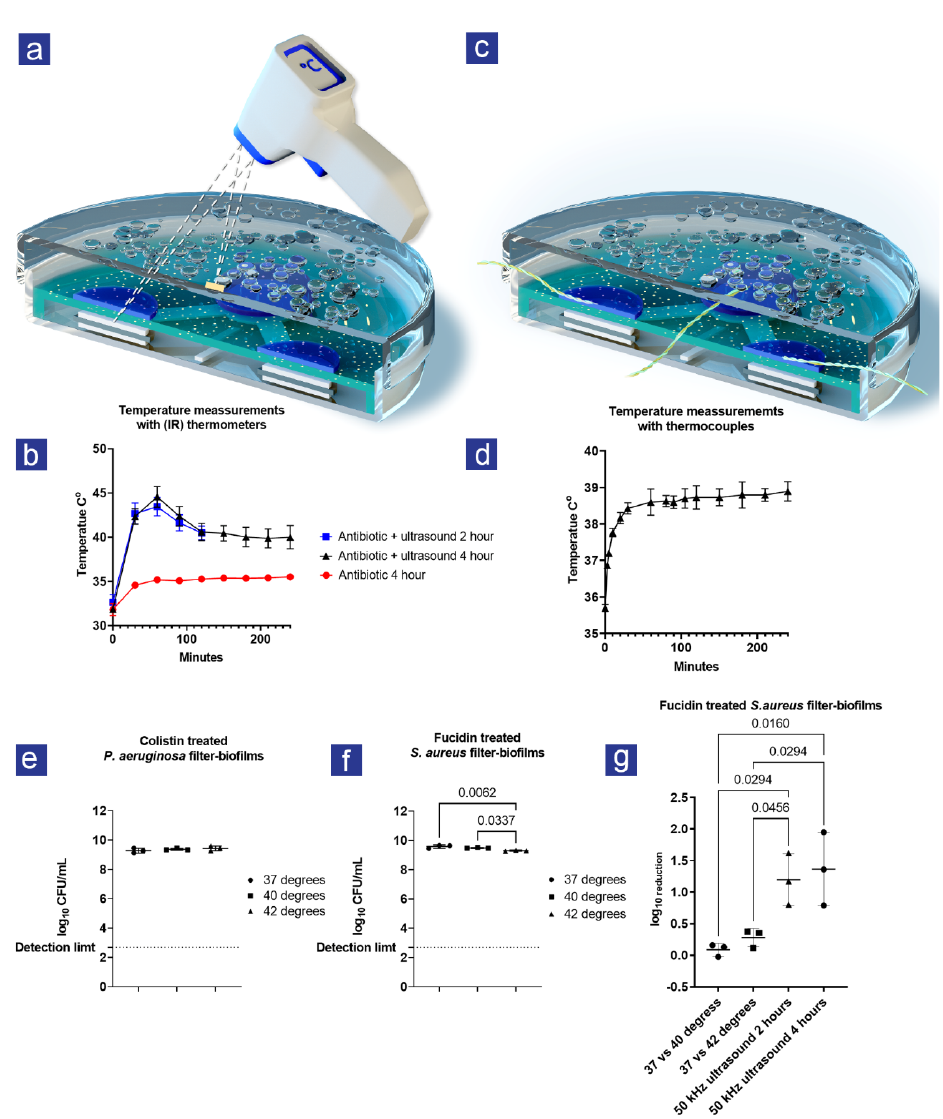
Figure 3. The effect of the temperature: ( a ) illustration of temperature measurement performed with an infrared (IR) thermometer; ( b ) temperature measurements over time measured with IR during 2- and 4-hour ultrasound treatment of S. aureus filter-biofilms; ( c ) illustrations of temperature measurement performed with type K thermocouples positioned at the surface level of the filter-biofilms; ( d ) temperature measurements over time with thermocouples at the surface level of the filter-biofilms during 4-hour ultrasound treatment; ( e , f ) graphs show logarithmic-transformed colony-forming units per milliliter (Log10 CFU/mL) for the combined effect of antibiotics and increase in temperature for P. aeruginosa and S. aureus treated filter-biofilms, respectively; ( g ) the logarithmic reduction (Log10 reduction) for temperature in combination with antibiotics and the combined effect of ultrasound and antibiotics. N = 3 for all experiments, except graph A (n = 6), and bars represent SD. Statistical tests were performed using one-way ANOVA; only significant differences ( p < 0.05) are shown.